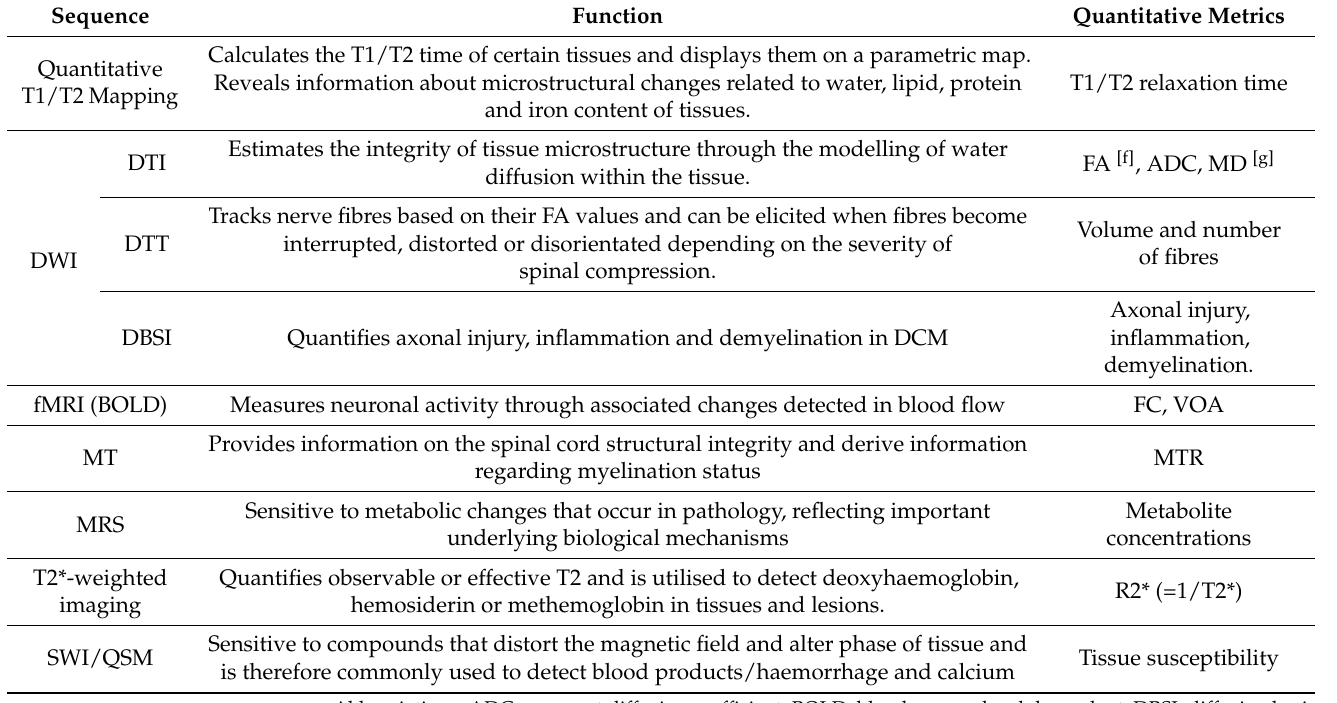
Table 3. Quantitative MRI sequences applicable in the context of myelopathy and their corresponding derived metrics [70,103–107,110–120]. Function Quantitative Metrics T1/T2 relaxation